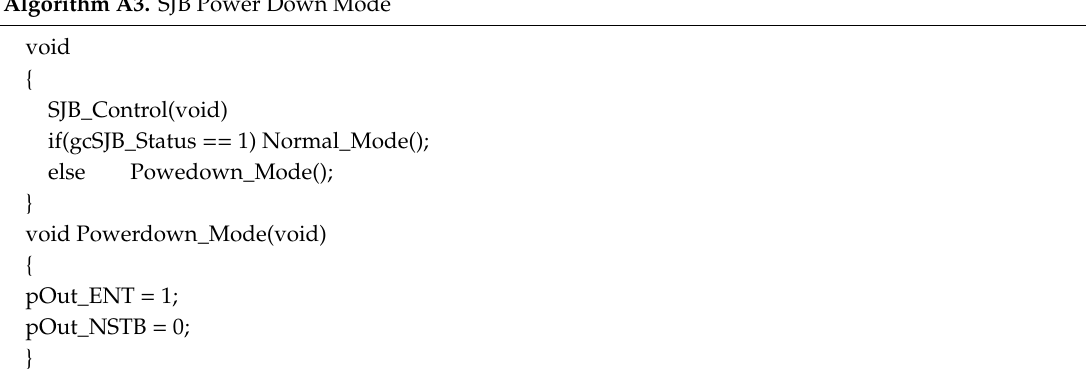
Algorithm A3. SJB Power Down